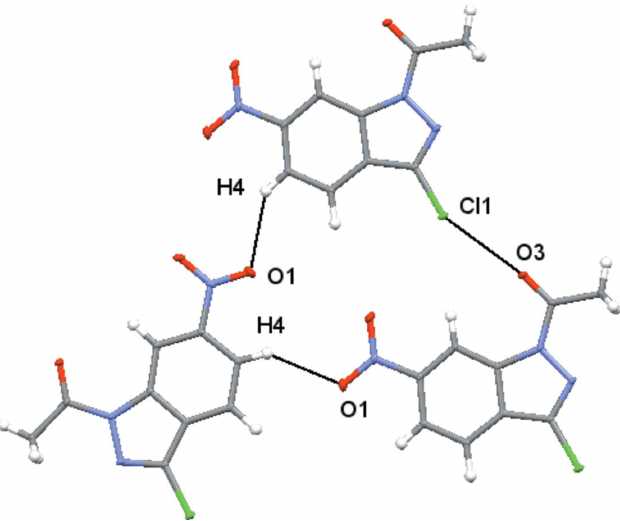
Figure 3 Detail of the R 3 (19) graph set formed by the Cl1 (cid:2)(cid:2)(cid:2) O3 interaction and 3